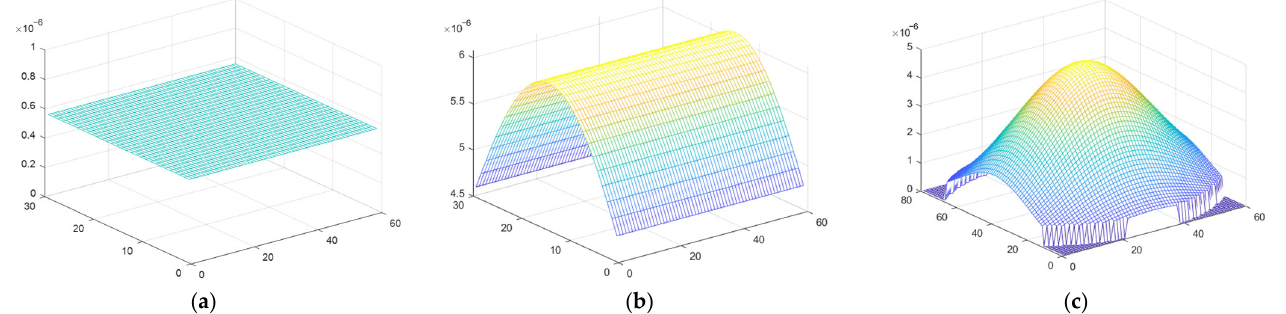
Figure 6. The illumination profile for: ( a ) windowed illumination; ( b ) line laser illumination; ( c ) spot laser illumination.